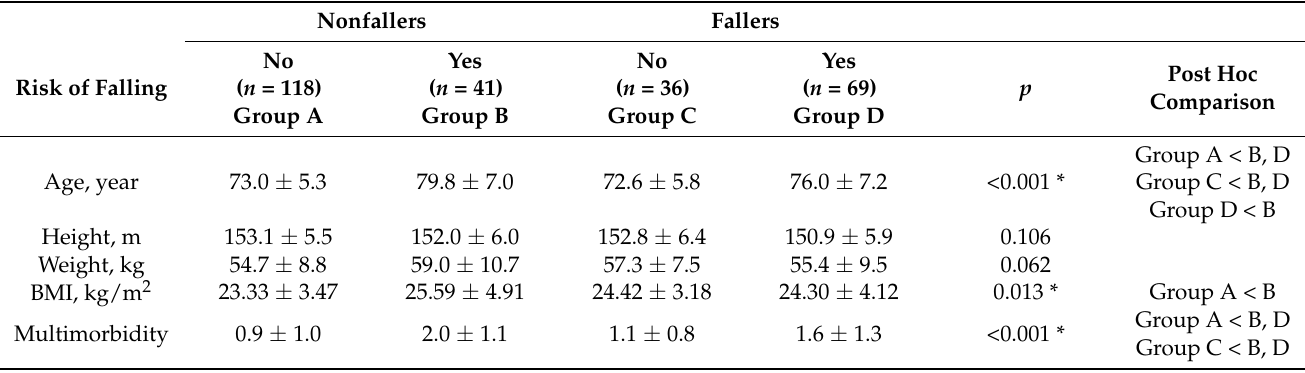
Table 1. Basic characteristics of the participants.